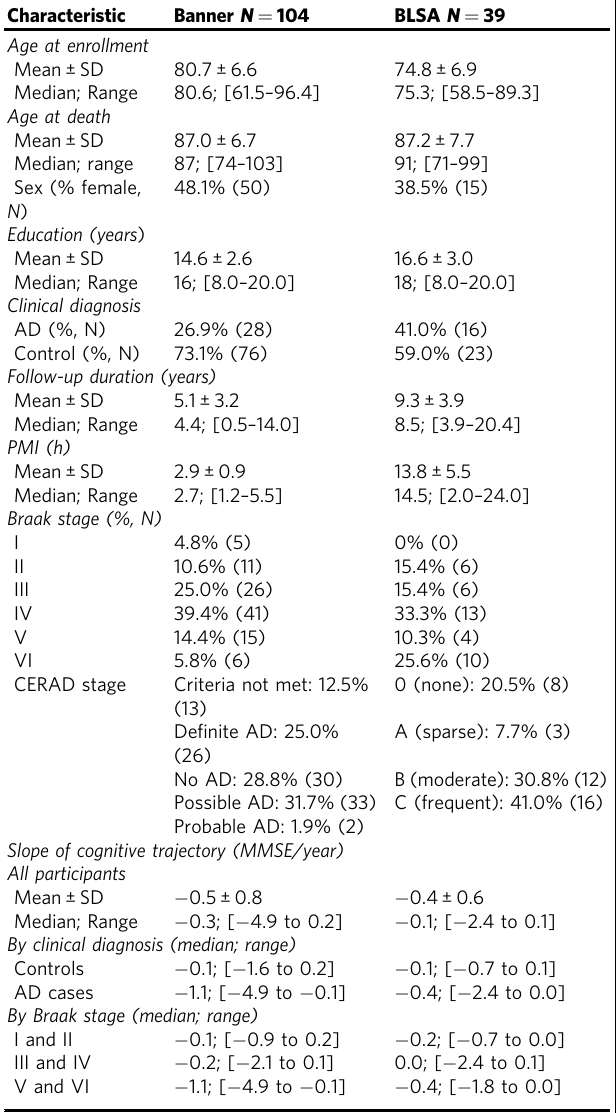
The table summarizes the demographic and clinical characteristics of the Banner (discovery) and BLSA (replication) cohorts. The following terms Alzheimer ’ s disease (AD), post-mortem interval (PMI), Mini-Mental State Exam (MMSE), and Consortium to Establish a Registry for Alzheimer ’ s Disease (CERAD) are used as acronyms in the table. The underlying data are available through the Synapse platform (https://www.synapse.org/#!Synapse:syn7170616 and https://www.synapse.org/#!Synapse:syn3606086) and Supplementary Data